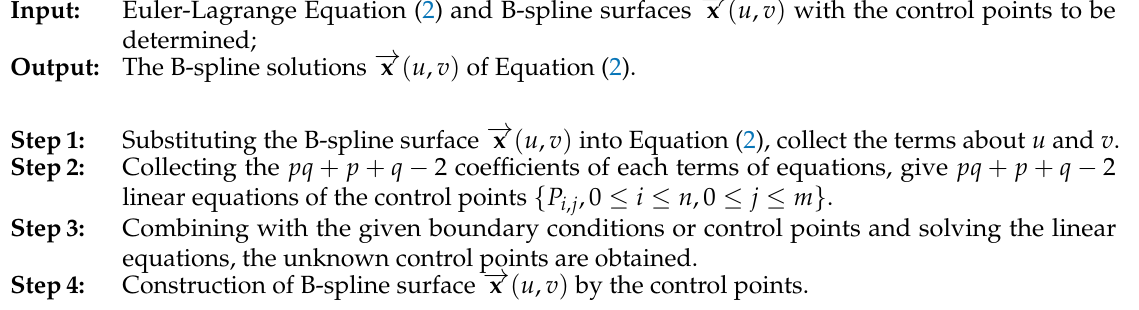
Algorithm 1 Algorithm to get the B-spline solution of Euler-Lagrange Equation